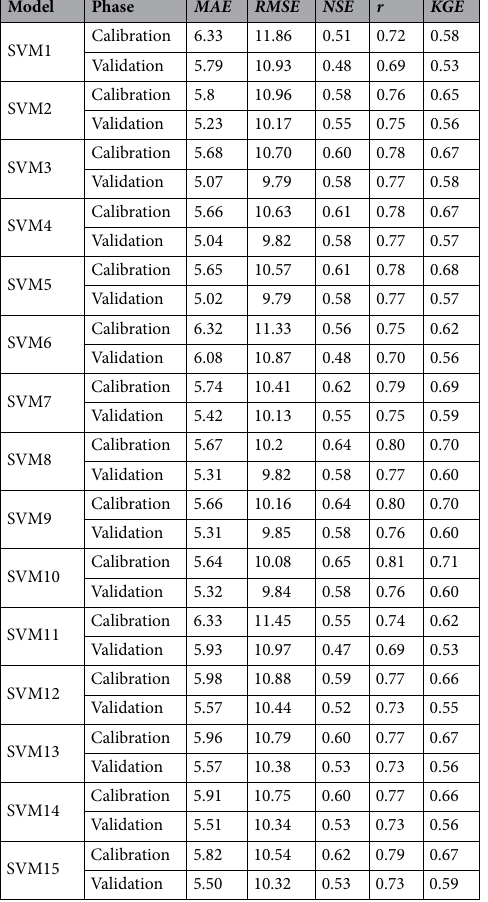
Table 9. The results of the applied metrics on the calibration and validation phases through different SVM